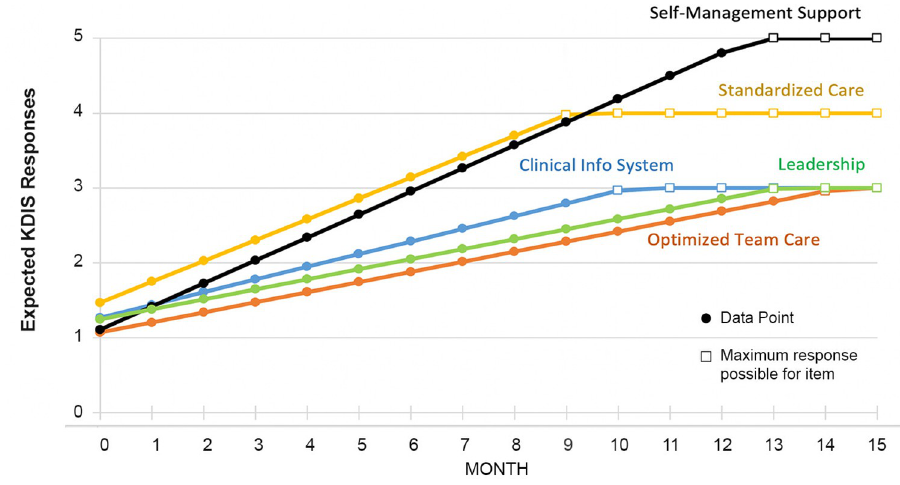
Fig 4. Expected trajectory for KDIS